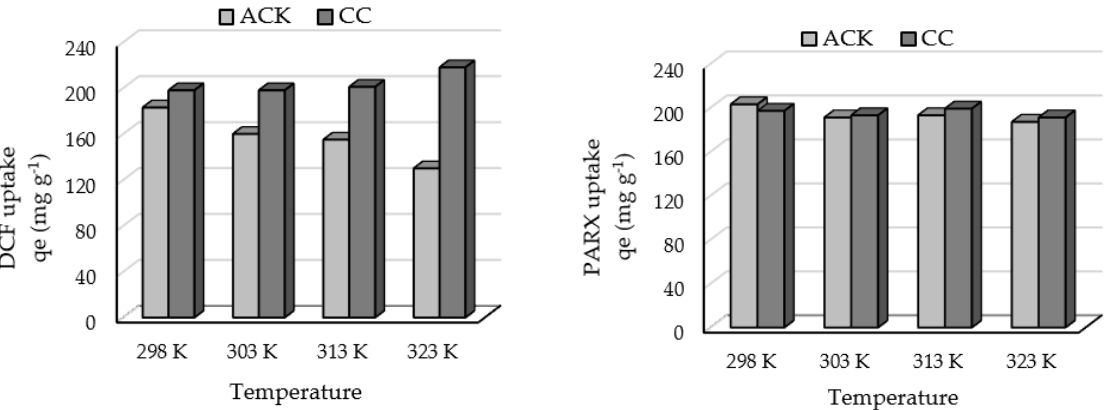
Figure 9. Effect of temperature on the adsorption capacity of DCF and PARX for ACK and CC carbons (Adsorbent mass = 10 mg; Contact time = 8 h (CC carbon) and 4 h (ACK carbon); PARX and DCF initial concentration = 100 mg L − 1 ; Solution volume = 25 mL; Solution initial pH = 6.0 (DCF) and 5.5 (PARX)).